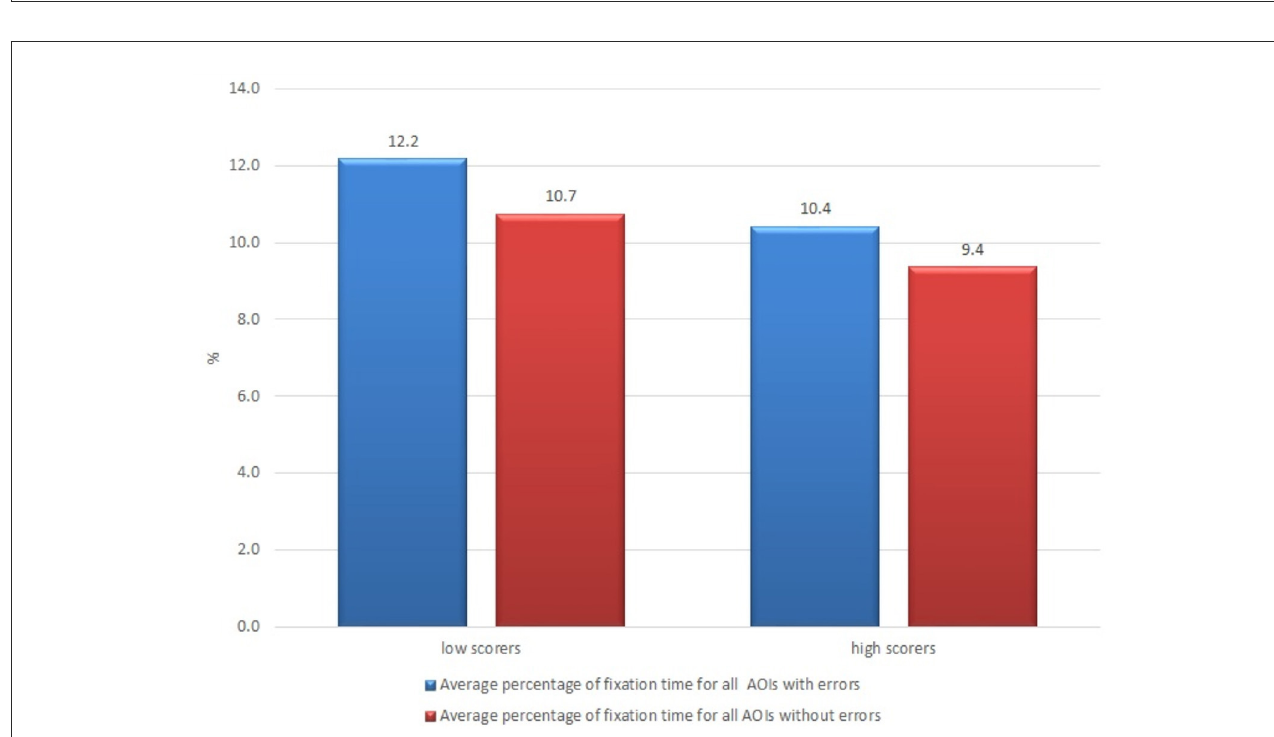
FIGURE6 Average percentage of fixation time of non-professional users who rated quality of the raw machine-translated text higher and lower than the